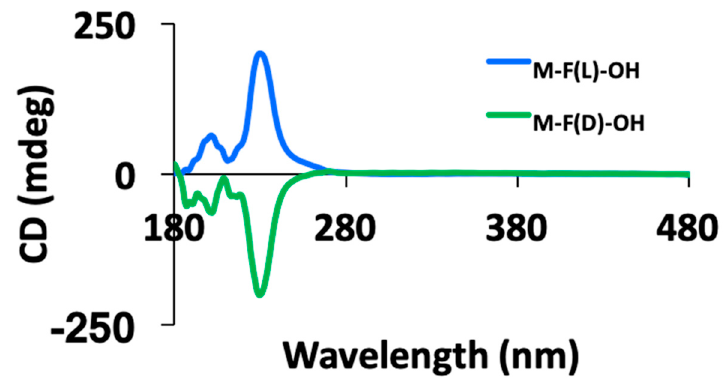
Figure 3. Circular dichroism (CD) spectra of MA- l -Phe-OH in blue and MA- d -Phe-OH in green showing both enantiomers being mirror images of each other in 1% gel state. The spectra also demonstrate a narrow peak and the self-assembling characteristics of phenylalanine as reported in the literature.